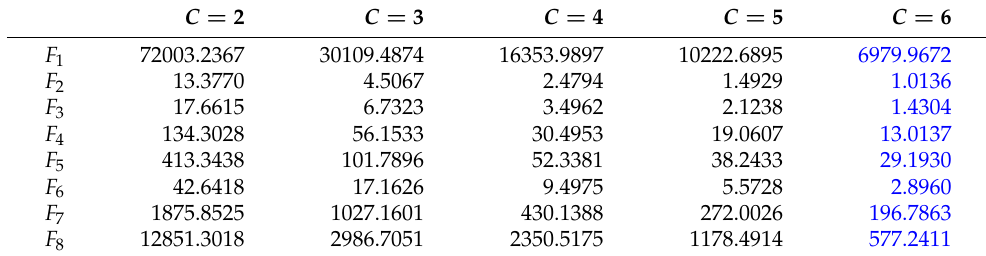
Table 4. Performance index using fuzzy c-means (best values in blue).